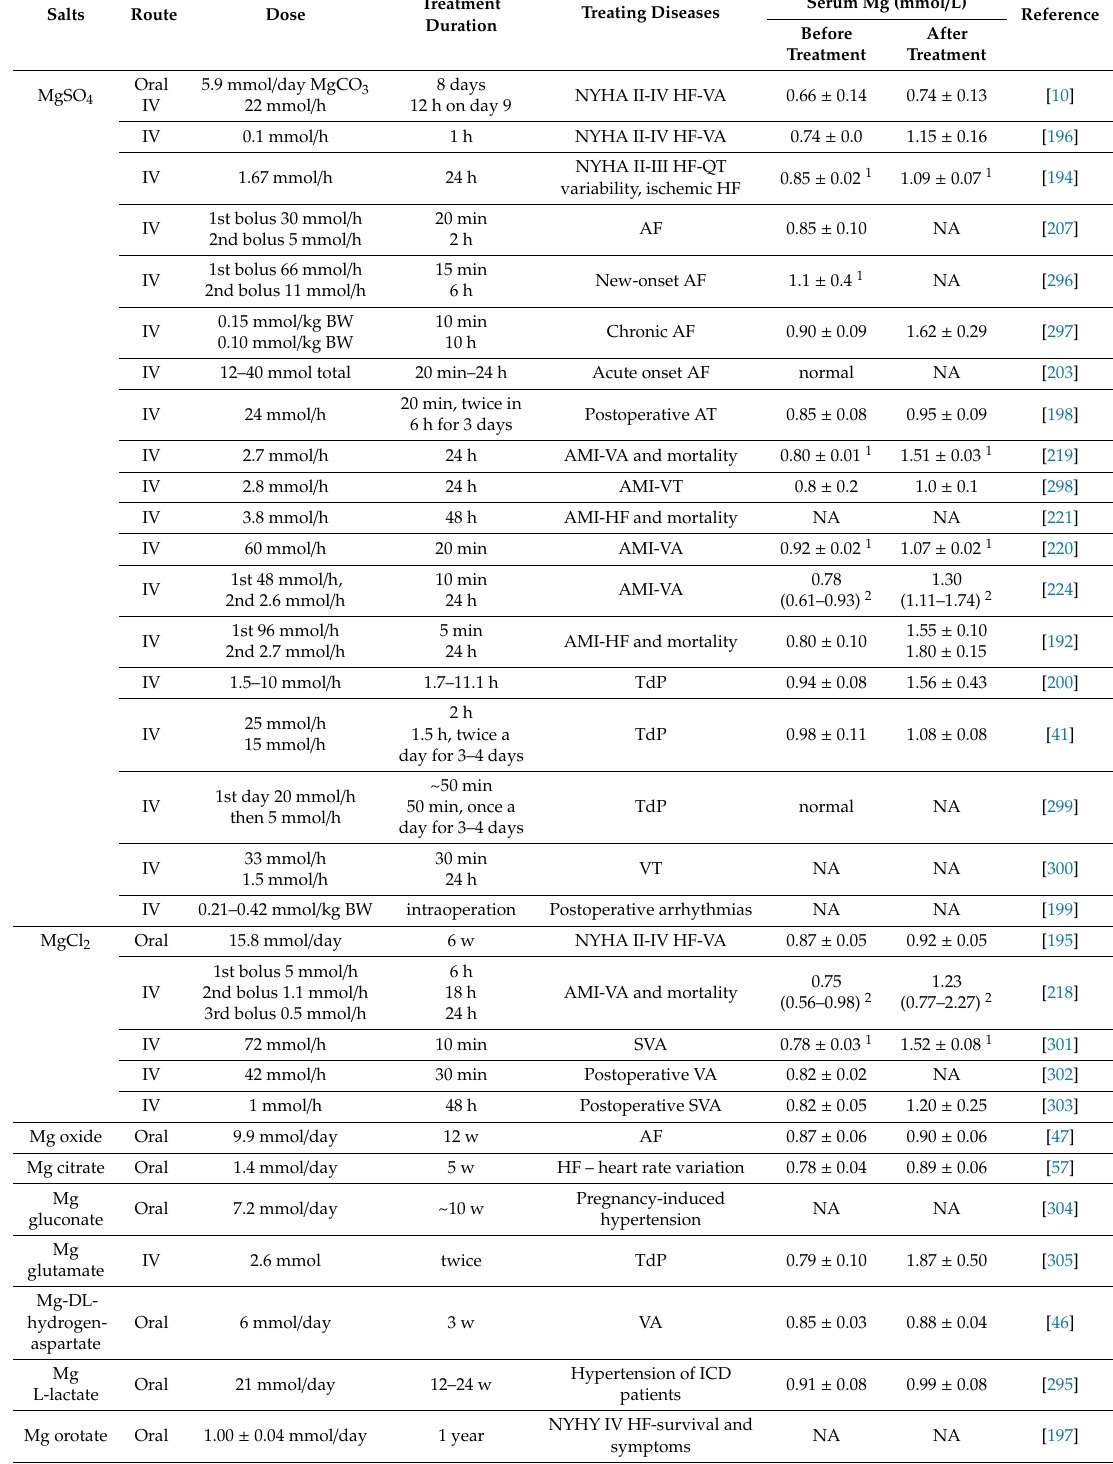
Table 2. Mg treatments in di ff erent salt forms, routes, doses, and treatment durations that present protective e ff ects in clinical studies on heart diseases. Serum Mg levels before and after Mg treatment are listed if tested in the studies. Serum Mg values are mean ± SD unless otherwise